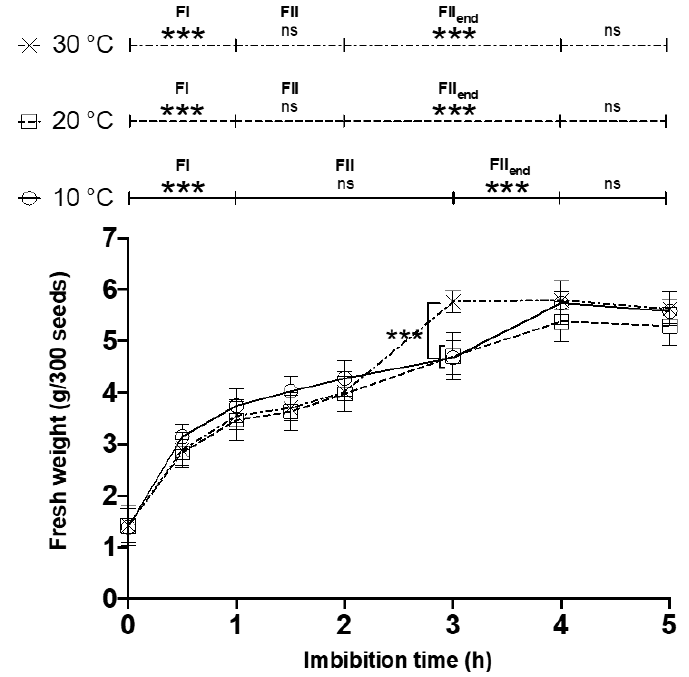
Figure 1. Imbibition curves of S. hispanica seeds at 10, 20 and 30 °C. Values are expressed as mean ± SD of five independent replicates. In the top is indicated the temporality of the imbibition phases FI, FII and FII end in each of the temperature treatments. Statistical analysis was performed using two-way ANOVA followed by a Tukey multiple comparison test. Asterisks correspond to data with statistical differences in time intervals and between temperature treatments ( *** p < 0.001).